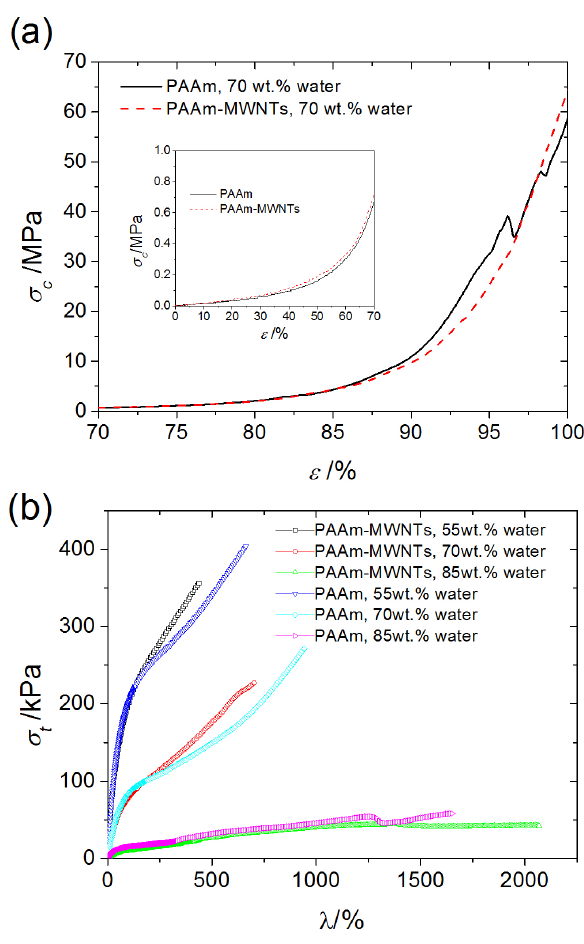
Figure 2: The compressive (a) and tensile (b) stress–strain curves of the PAAm hydrogels without MWNTs and surfactant and PAAm- MWNTs hybrid hydrogels. The PAAm-MWNTs hybrid hydrogels contained 0.2 wt.% MWNTs